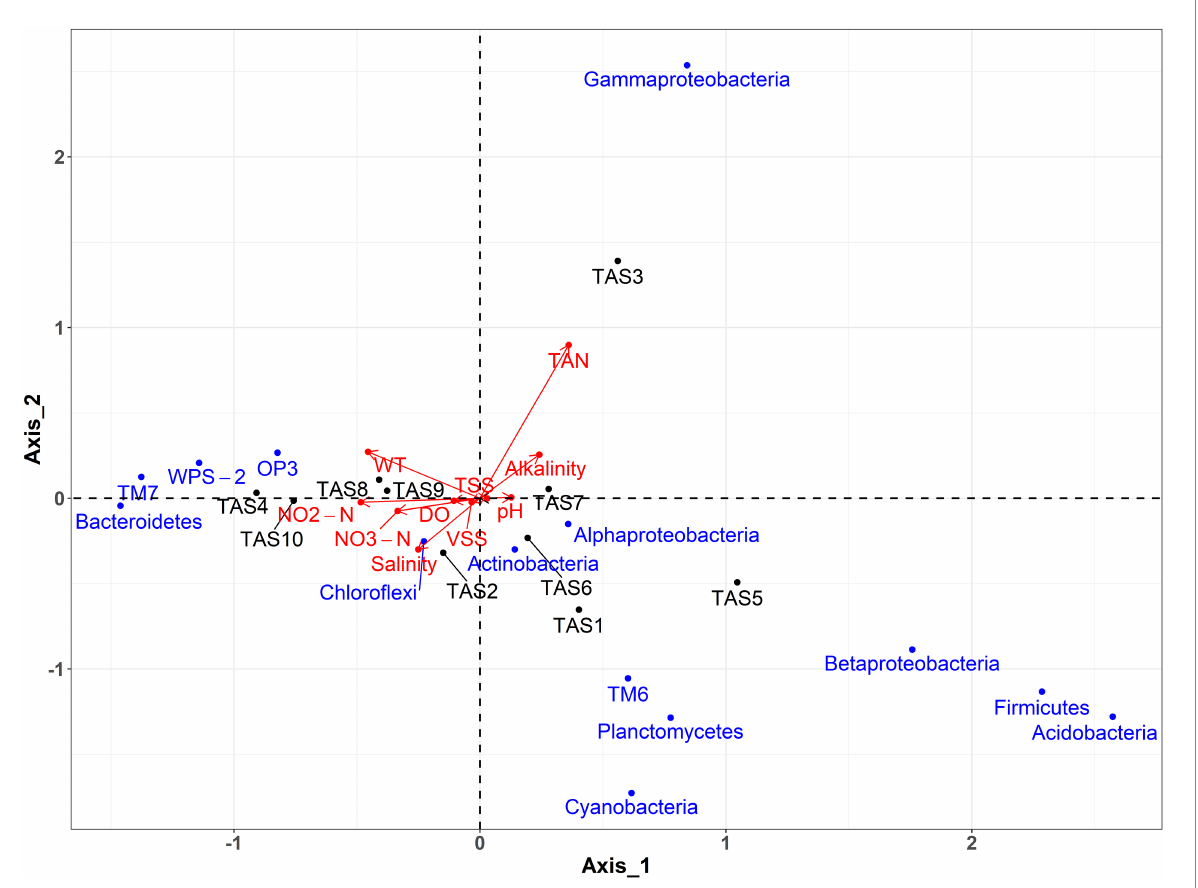
FIGURE 6 Physicochemical parameters of rearing water responsible for bacterioplankton community changes. Canonical correspondence analysis (CCA) shows an association between the dominant bacterioplankton groups (at phylum/class level) and the physicochemical properties of rearing water. WT, water temperature; TAN, Total ammonia nitrogen; TSS, total suspended solid; VSS, volatile suspended solid. The culture stages (TAS1 to TAS10) represent shrimp Litopenaeus vannamei growth days 6, 20, 34, 48, 69, 83, 104, 118, 132, and 146,